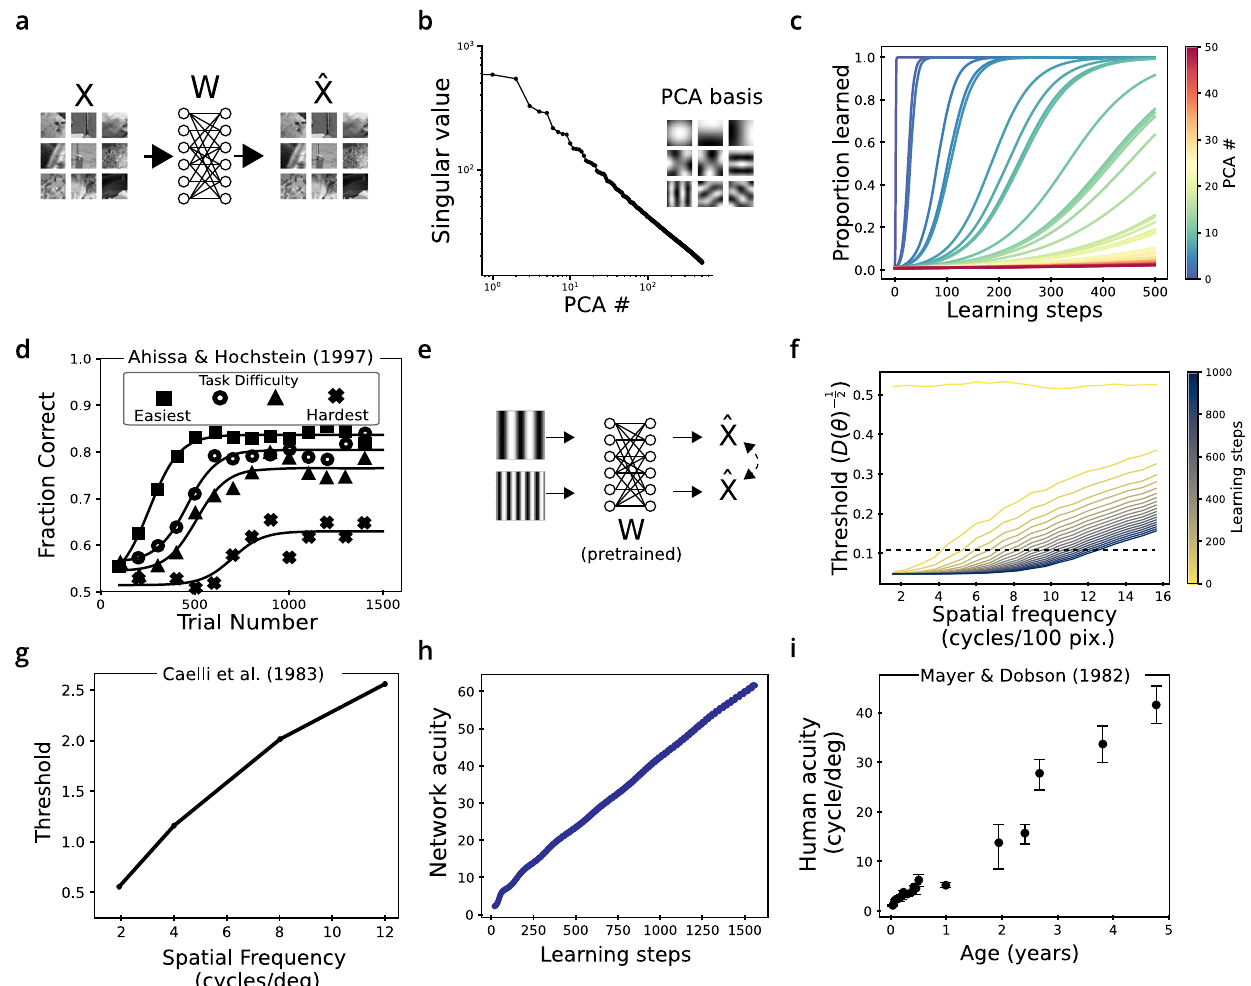
Fig. 5 | The effect of input statistics on network sensitivity can be understood with linear network models. Despite their simplicity, these show human-like learning phenomena. a We trained linear networks to reconstruct black and white patches of natural images. b The statistics of natural images can be analyzed with Principal Components Analysis (PCA); the variance of each successive PC decrea- ses with a characteristic power law decay. c When learning with gradient descent, the weight matrix W learns each PC separately and in order of their variance. The sharpness of the sigmoidal learning curve is controlled by the network depth (SI Fig.2) d Humanperceptuallearning curvesare alsosigmoidal, andincreasingtask dif fi cultydelayslearningdynamics.Datareplottedfromref.49;subjectstrainedto detect the orientation of a line, and the dif fi culty of the task was controlled by a